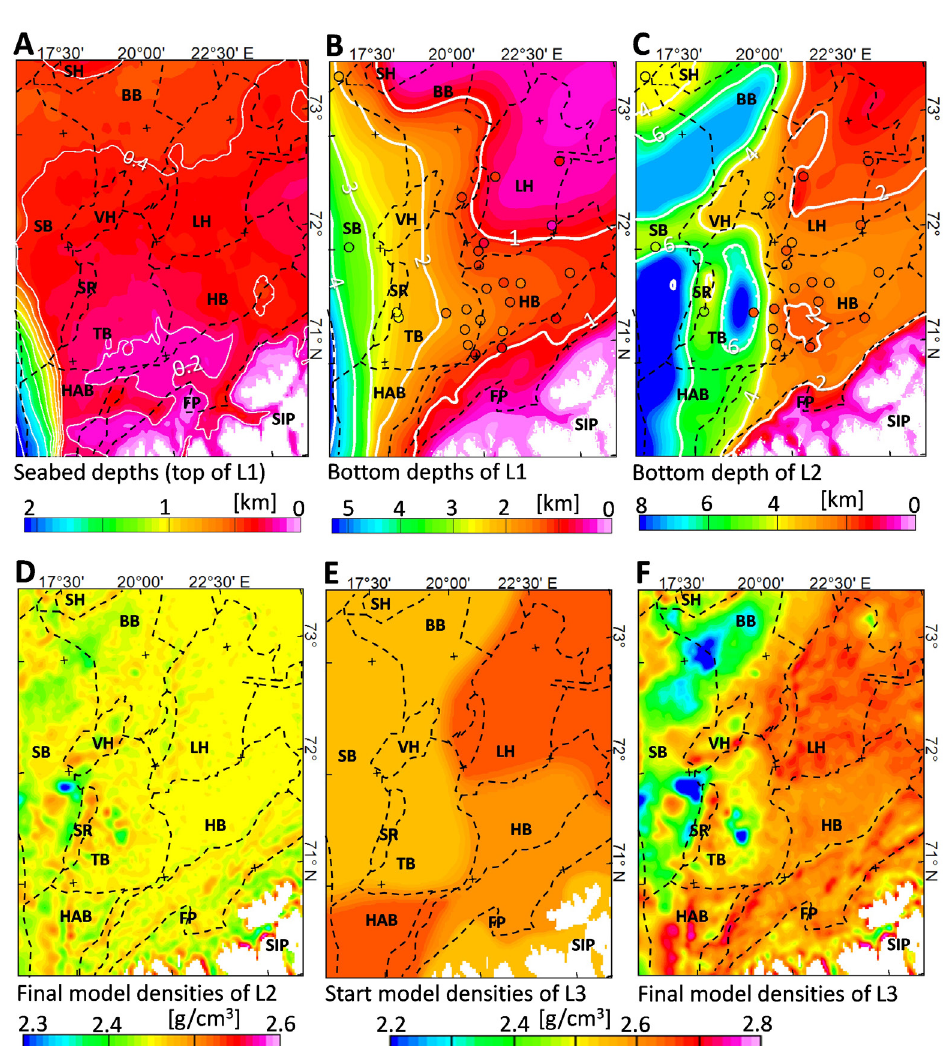
Figure 4. Sedimentary density model layers (see Table 1 for details). (A) Seabed depth (equals the top of unit L1). (B) Bottom depth of unit L1 (equals the top of unit L2) with depths derived from density well logs, shown by the coloured fill of the circles at the well locations. (C) Bottom depth of unit L2 (equals the top of unit L3) with depths derived from density well logs, shown by the coloured fill of the circles at the well locations. (D) Final model densities of unit L2. (E) Start model densities of unit L3. (F) Final model densities of unit L3. Boundaries of structural elements (black dashed, details in Fig. 1, abbreviations in Fig.